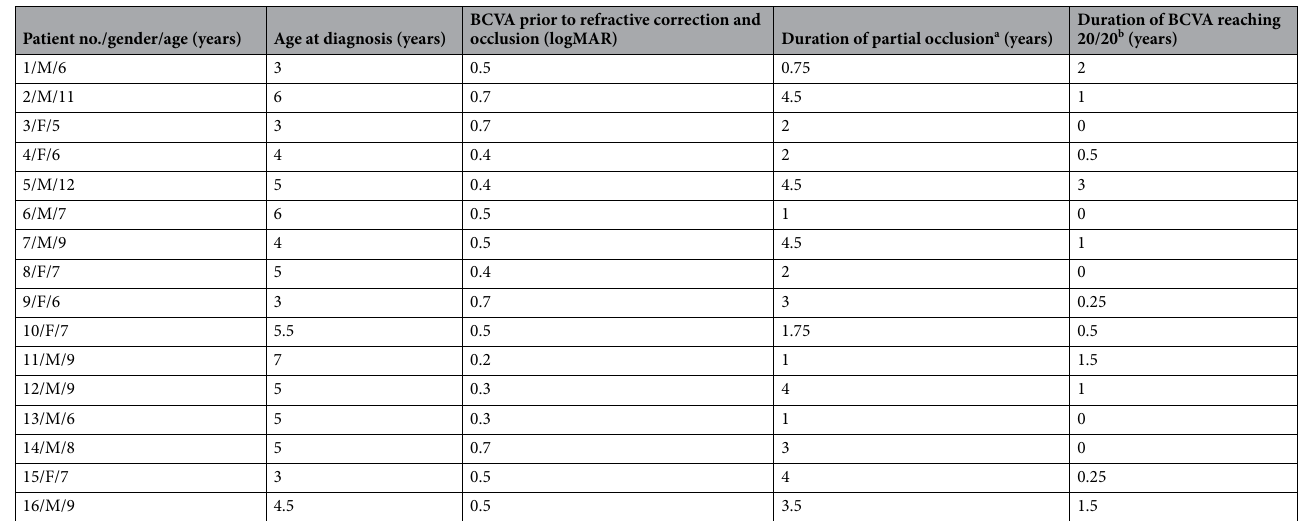
Table 2. Treatment summary of recovered amblyopic children. a Together with refractive correction. b Refractive correction was continued if needed.